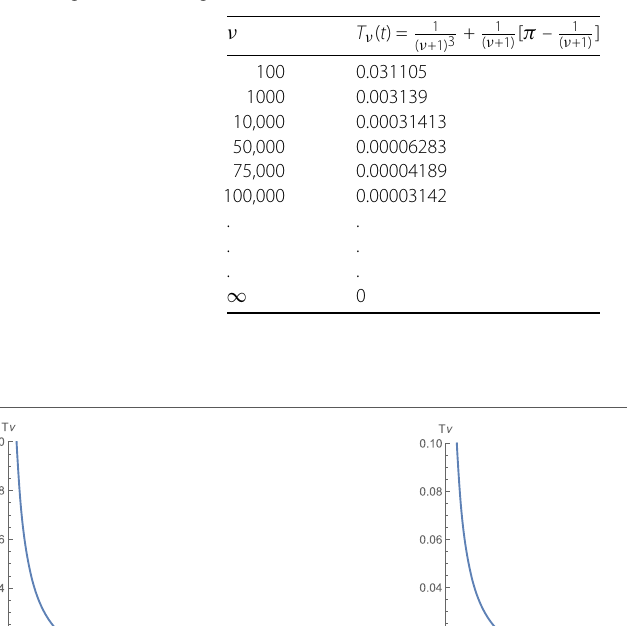
Table 1 Degree of convergence of f ( t ) = t 3